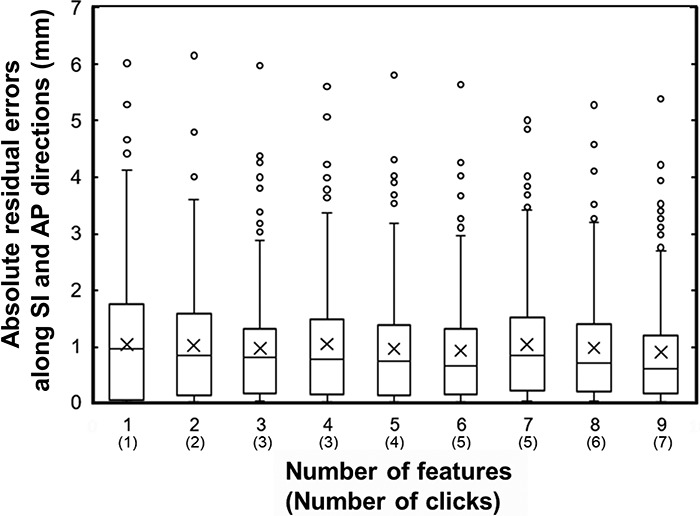
Relationship between absolute residual errors along the SI and AP directions and the number of features in SVR for the validation test. The number of clicks to acquire the features are shown in parentheses.